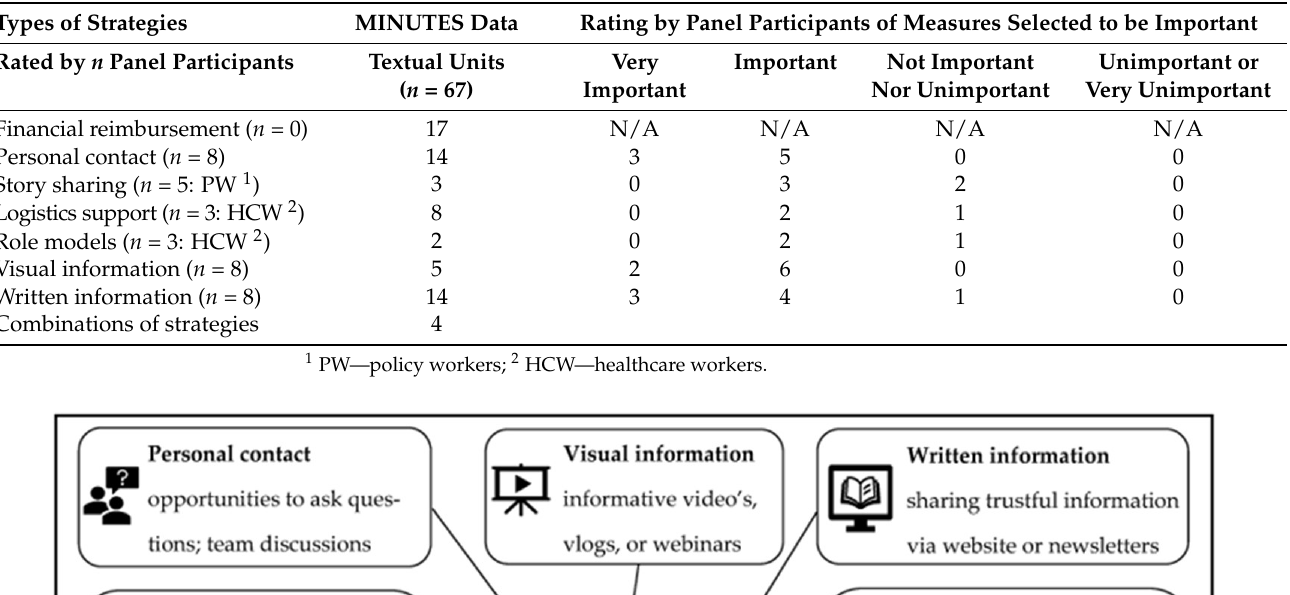
Table 2. Types of strategies described in the MINUTES study and rated by panels of NH staff.